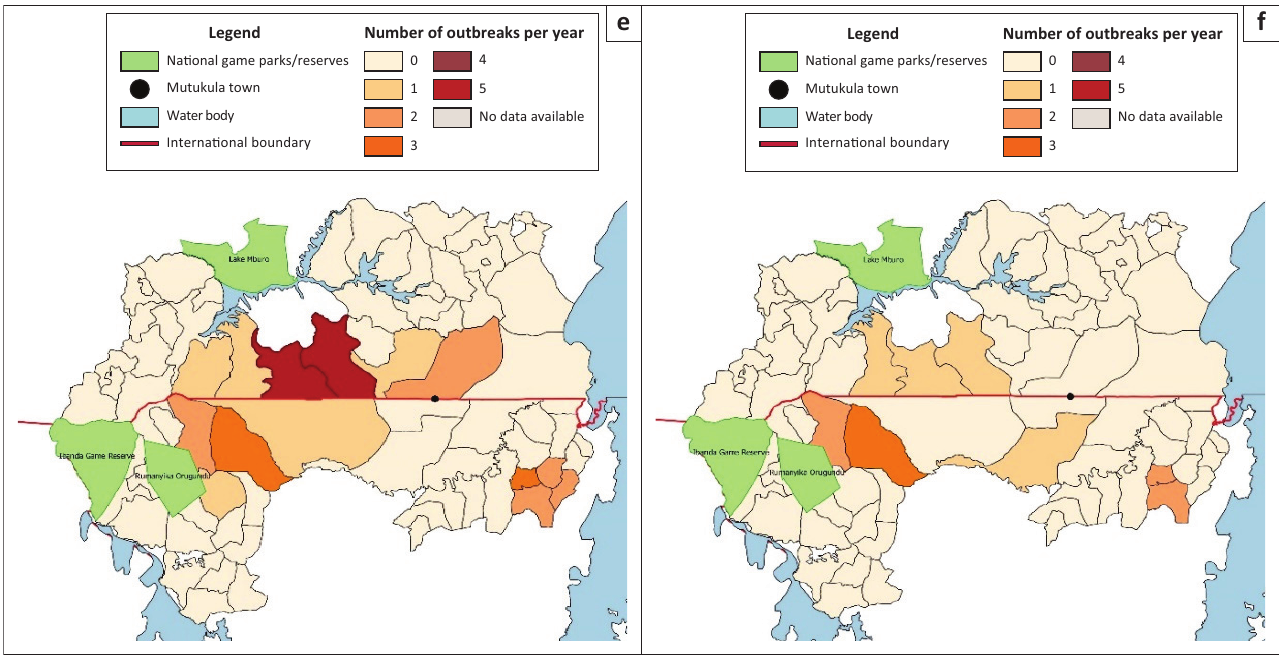
FIGURE 2: Spatial distribution of foot-and-mouth disease in sub-counties and/or wards in border districts of Uganda and Tanzania between 2011 and 2016.